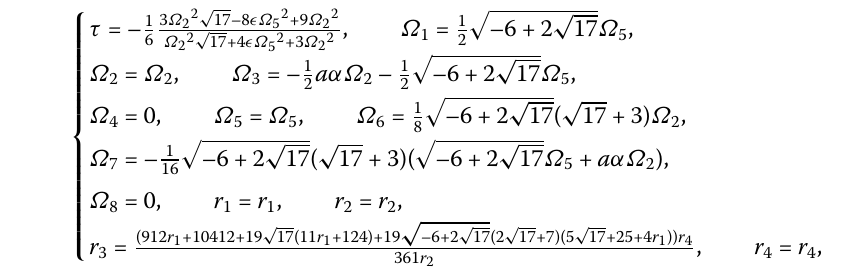
Likewise, by selecting suitable values of the parameters the graphic representation of pe- riodic wave solution is presented in Fig. 12, containing the 3D plot, density plot, and 2D plot when three spaces arise at spaces x = –1, x = 0, and x =